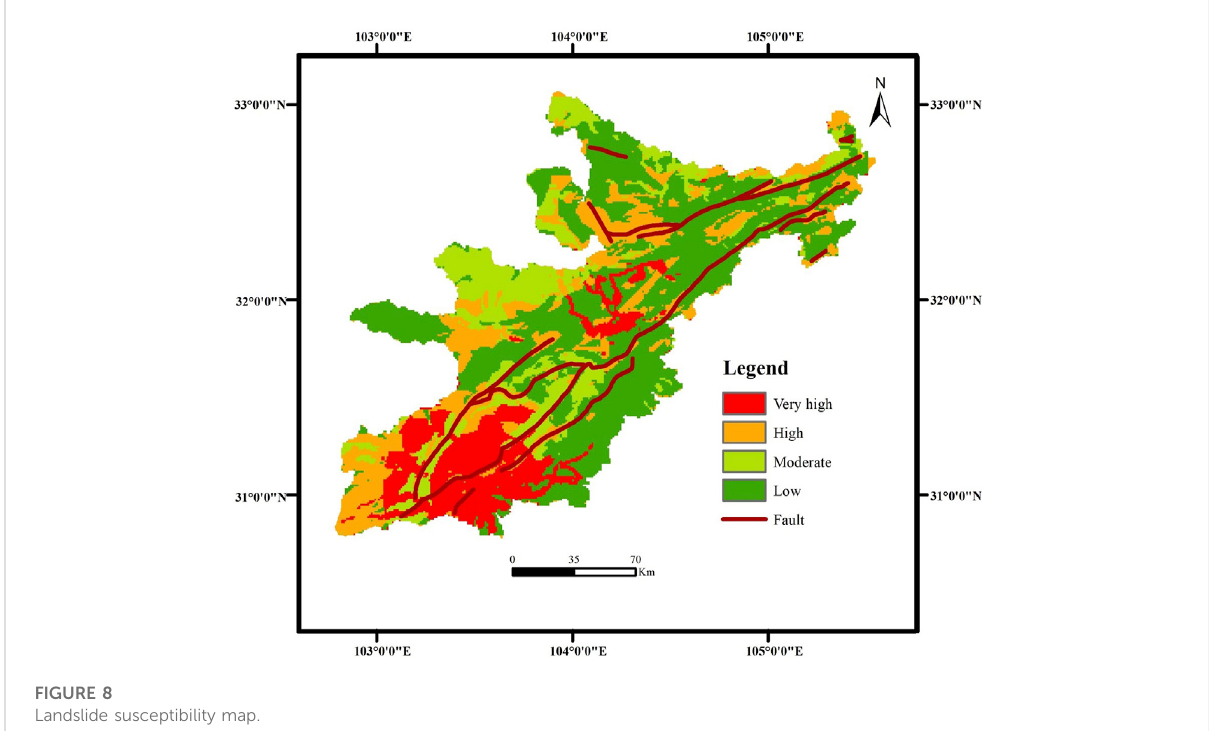
FIGURE 8 Landslide susceptibility map.